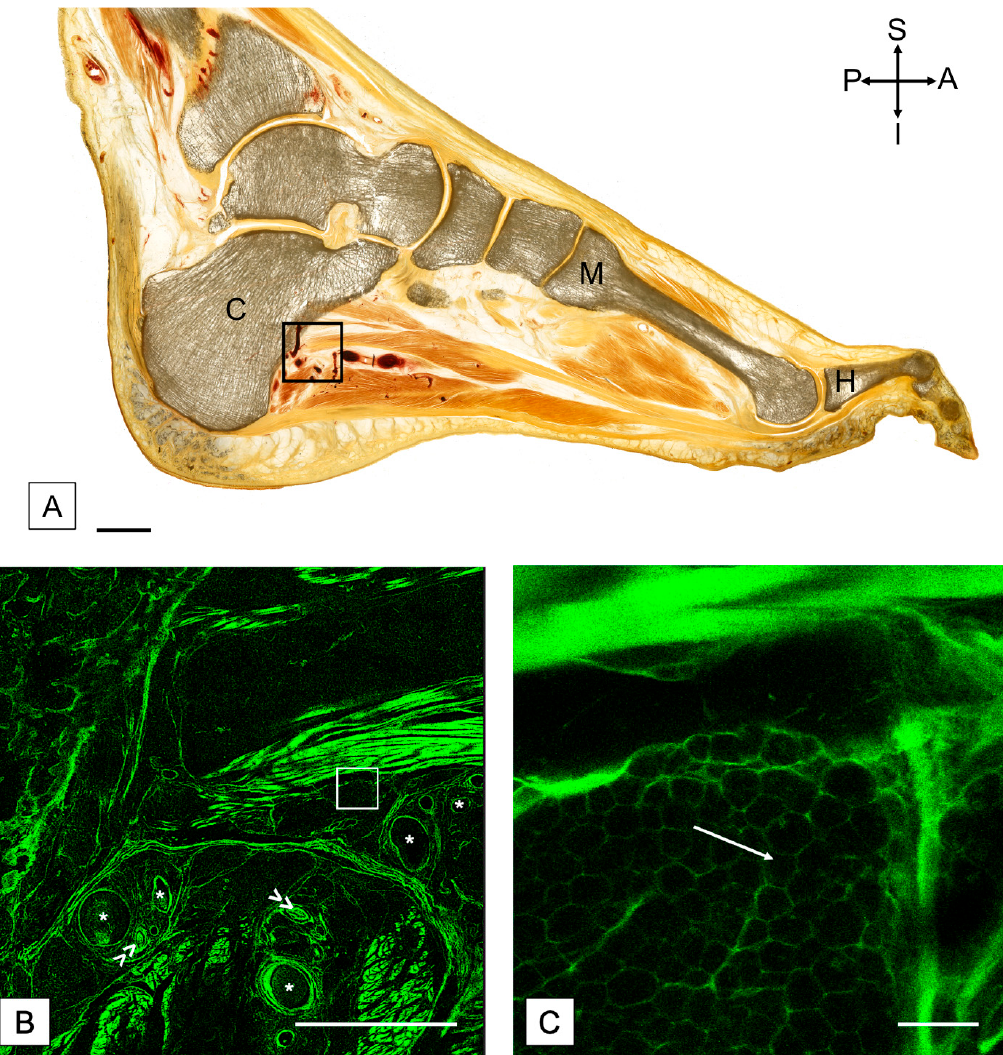
Figure 2. ( A ) Plastinated sagittal section of a foot with confocal images to demonstrate the adipose tissue. The black square indicates the region shown in ( B ). Scale bar = 15 mm. A = anterior; C = calcaneus; H = hallux; I = inferior; M = metatarsal; P = posterior; S = superior. ( B ) Confocal scan of a region distal to the calcaneus, including vessels. The white square represents the region shown in ( C ). ( C ) Confocal scan with higher magnification to highlight the adipose tissue. White arrow points towards adipose tissue present between slips of muscle in the foot. Scale in ( B ) = 5 mm, and scale in ( C ) = 200 µ m. Asterisk (*) = blood vessel. Double arrow (>>) = nerve